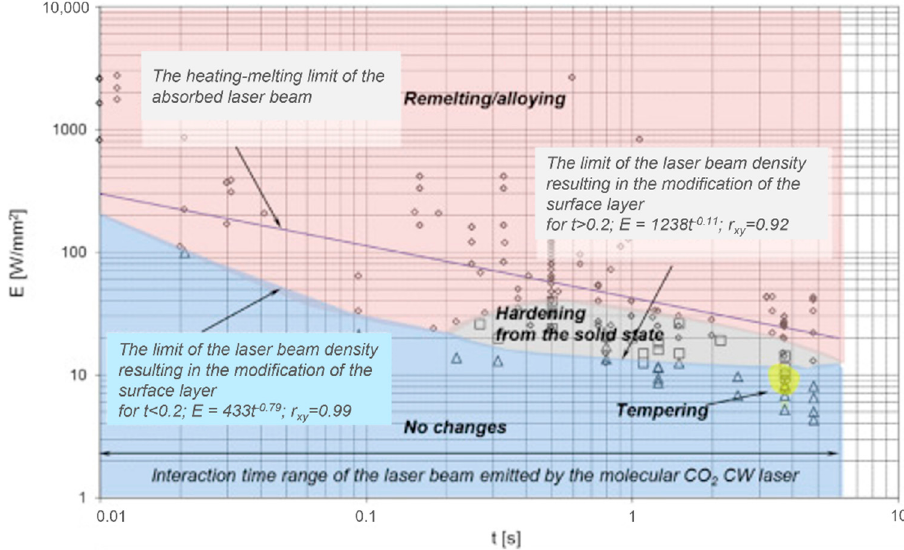
Figure 7. Energy density ranges for different heat treatments with CO 2 lasers on GI (Reprinted with permission from ref. [46]. 2016 Elsevier).